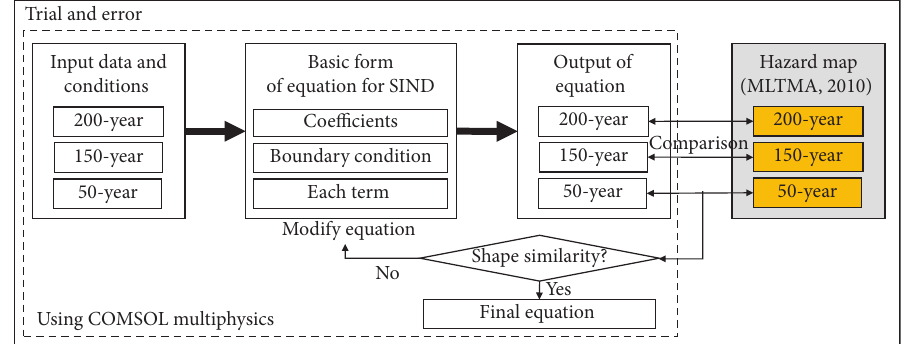
Figure 3: Process of derivation equation for storm surge in the SIND